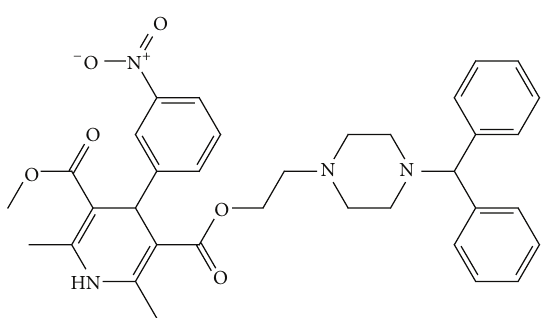
Figure 1: Chemical structure of